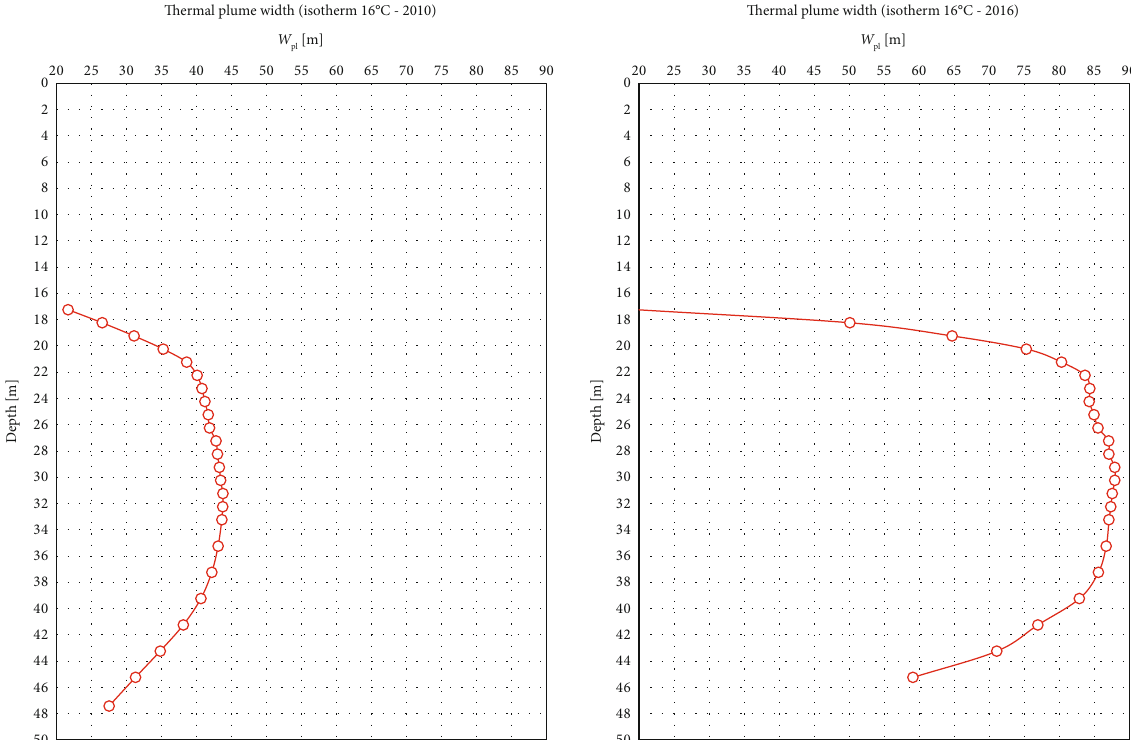
Figure 9: Simulated vertical variation of thermal plume width ( W